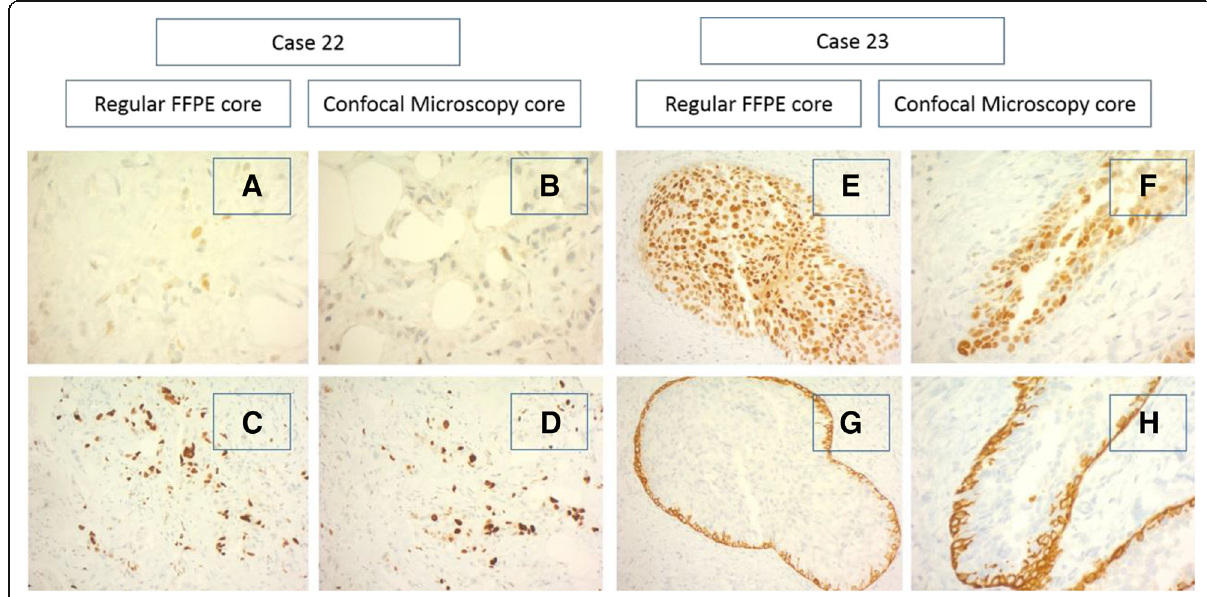
Fig. 5 Pictures show the negligibly small effect of the preparation process for scanning on the final pathologic routine: On-site scanning procedure did not interfere with the subsequent control immunohistochemical staining process. Immunohistochemical stains of two cases. Case 22: invasive ductal (NST) carcinoma. a and b : Estrogen receptor (ER) stain, low expression. a HE stain, regular formalin fixation. B HE stain, formalin fixation after confocal microscopy. c and d : Ki-67 proliferation index. c HE stain, regular formalin fixation. d HE stain, formalin fixation after confocal microscopy. Case 23: high grade DCIS. e and f : ER stain, high expression. e HE stain, regular formalin fixation. f HE stain, formalin fixation after confocal microscopy. g and h : Basal cytokeratins (CK5/6). g HE stain, regular formalin fixation. h HE stain, formalin fixation after confocal